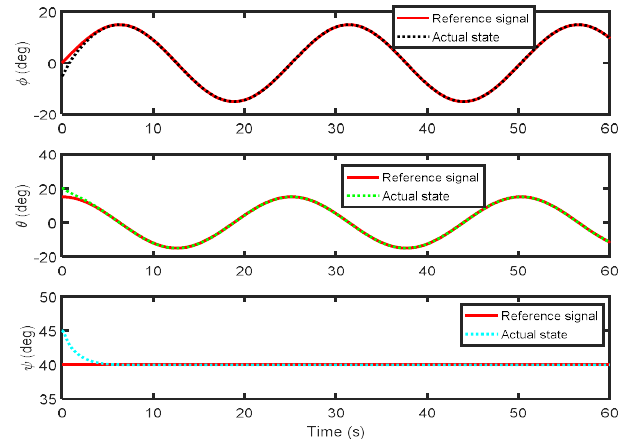
Figure 3. Attitude tracking response.